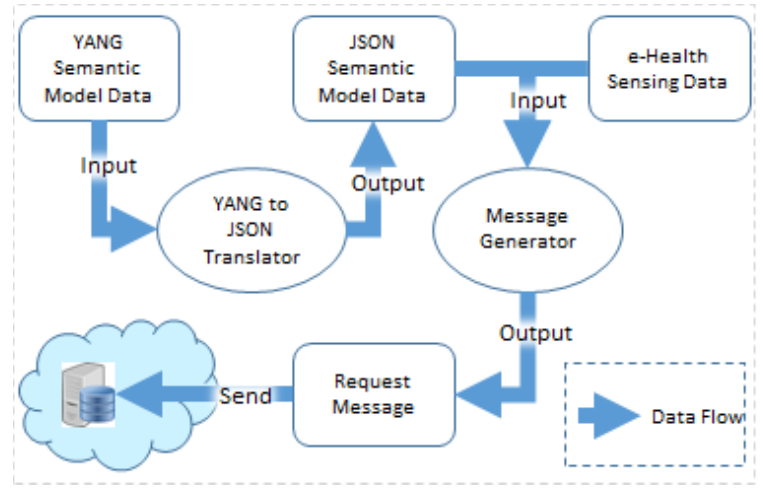
Figure 3. Data flow for semantic interoperability using the proposed semantic model.